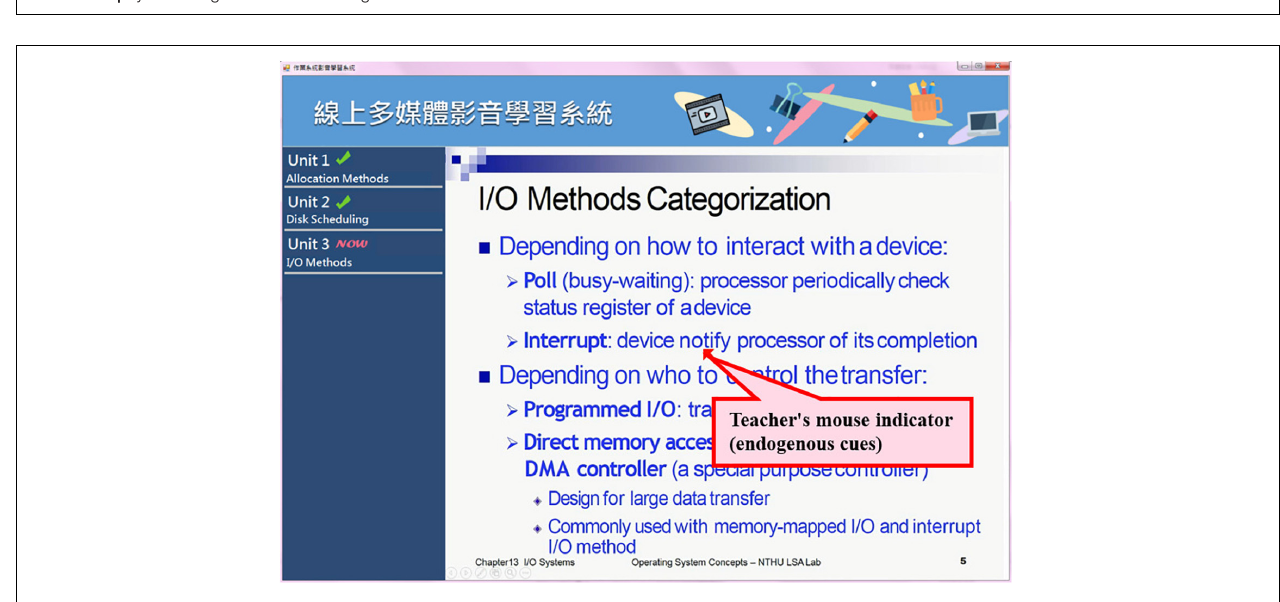
FIGURE 1 | Eye-tracking multimedia learning environment.